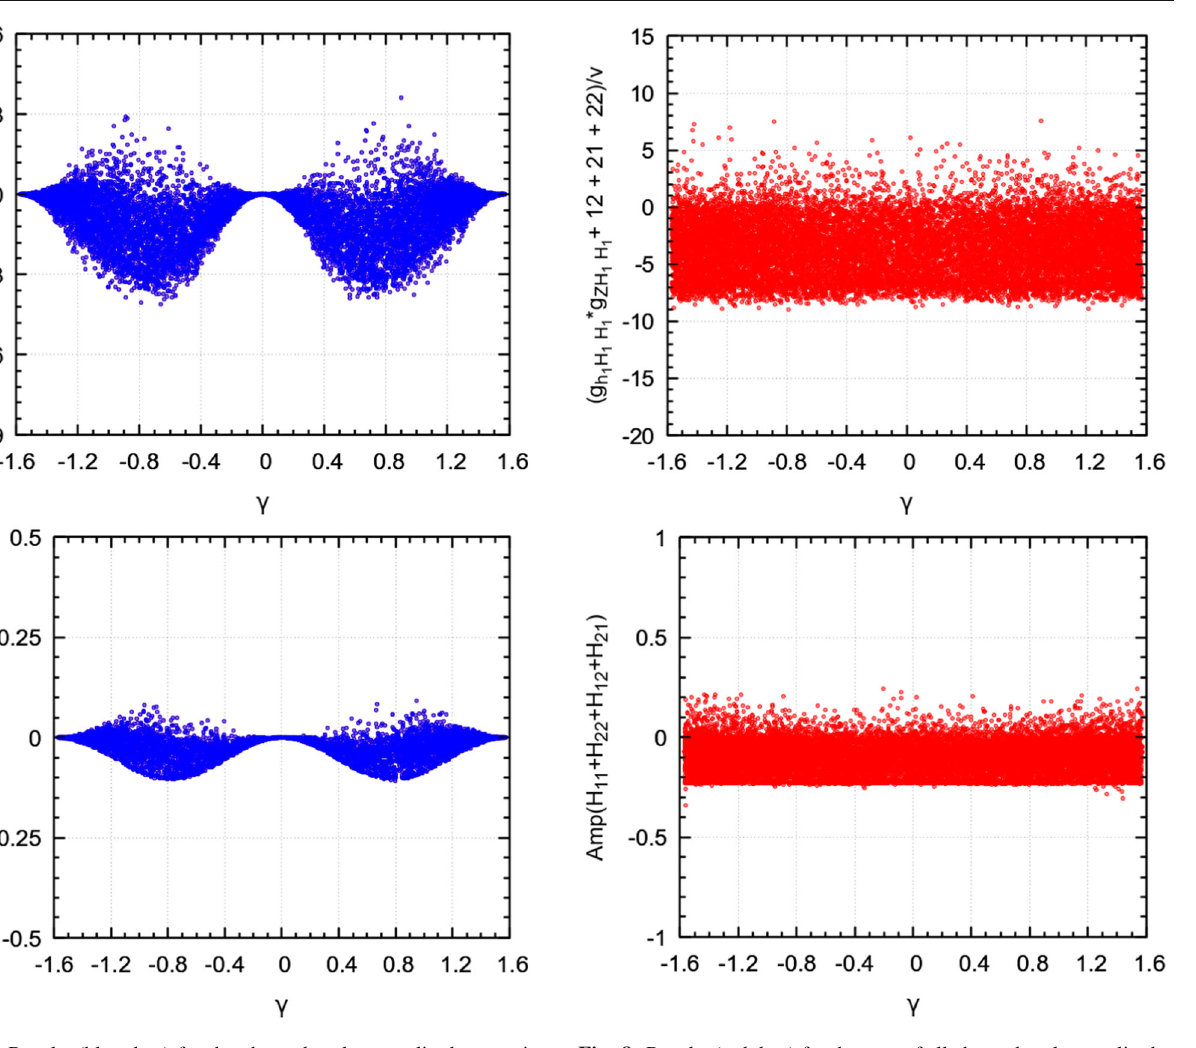
Fig. 7 Results (blue dots) for the charged scalars amplitudes contri- bution to h → Z γ in the case of having both H ± the loop, as a function of the mixing angle γ . On the upper panel the coupling products and on the lower panel the actual amplitudes